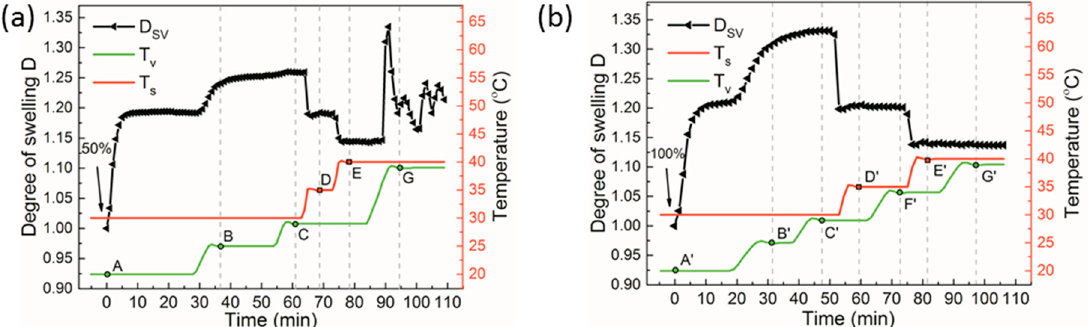
Figure 5. Swelling kinetics (left hand axis: black curves) of ~40 nm thick PS-PVP films (a) under chloroform vapor with partial vapor pressure of 50%, and (b) under toluene vapor with p/p 0 of 100% at stepwise increasing of T v and T s (right hand axis: green curves and red curves, correspondingly). Temperature set T v / T s are the following: (A,A’)—20 °C/30 °C, (B,B’) —25 °C/30 °C, (C,C’) —29 °C/30 °C, (D,D’) —29 °C/35 °C, E—29 °C/40 °C, E’—34 °C/40 °C, F’—34 °C/35 °C, (G,G’) —39 °C/40 °C.